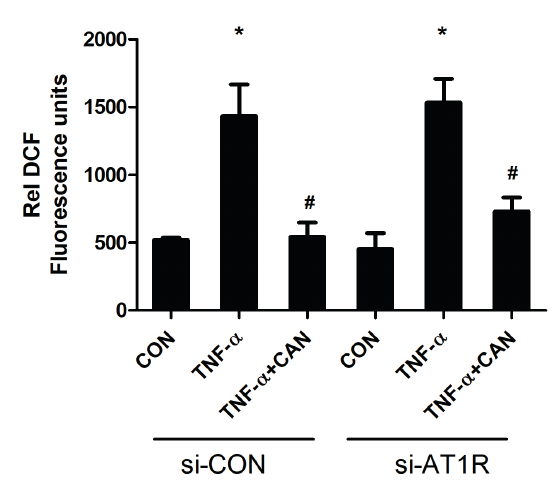
Figure 4 - Candesartan blunts TNF- α induced ROS production. HKC were transfected with AT1R siRNA or scrambled siRNA. 24 hours later, cells were treated with TNF- α (2ng/ml) along or TNF- α combination with candesartan (10 -5 M) for another 24 hours. Cell lysates were collected to measure ROS generation by DCF fluorescence assay. n=3. *P < 0.05 vs. CON, # P < 0.05 vs. TNF- α treatment; CON: control; CAN: